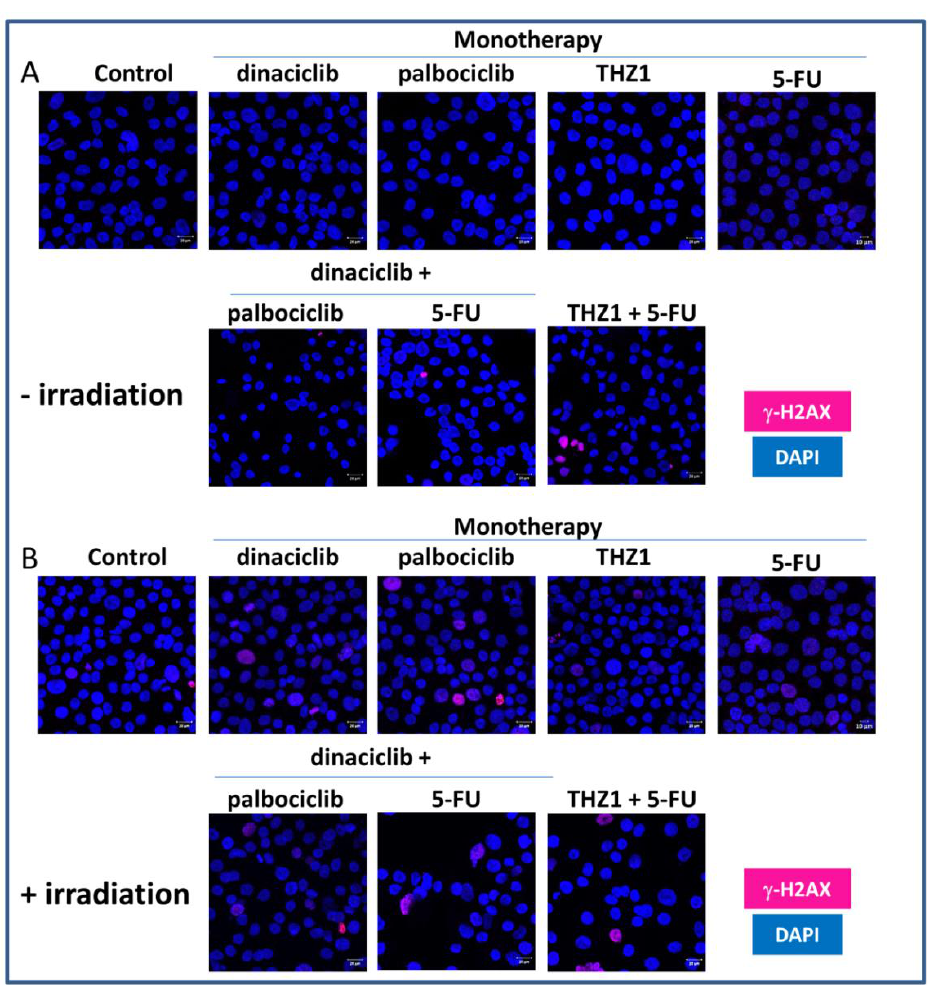
Figure 4. γ-H2AX staining of UT-SCC-14 cells. In order to detect a potential radiosensitizing effect of the test substances, cells were treated 24 h with selected monotherapy and combination therapies and then irradiated with 2 Gy using an IBL637. ( A , B ) We had three control groups. The first was completely untreated, the second was treated with the test substances but not irradiated, and the third was only irradiated but not treated with the test substances. Drug doses were as follows: dinaciclib [0.005 µM]; palbociclib [1 µM]; THZ1 [0.02 µM]; 5-FU [0.32 µg/mL]; γ-H2AX staining was performed 6 h after irradiation. Cell nuclei were stained with DAPI. Images were taken on a Zeiss LSM-780 Confocal Laser Microscope.